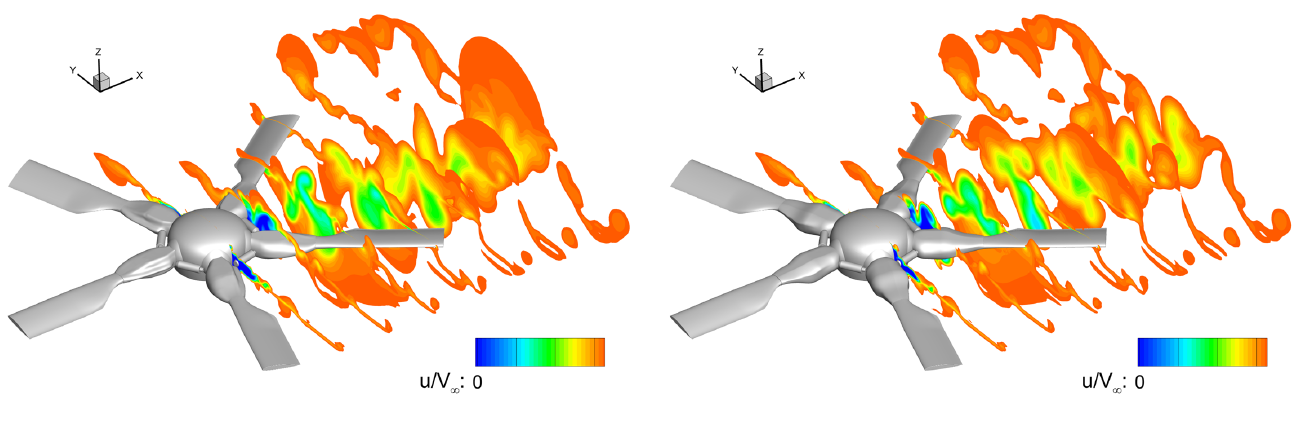
Figure 21. Normalized axial flow velocity u / V ∞ shown in seven equally spaced slices in the wake region of the rotor head. All velocities above 0.99 u / V ∞ are cut